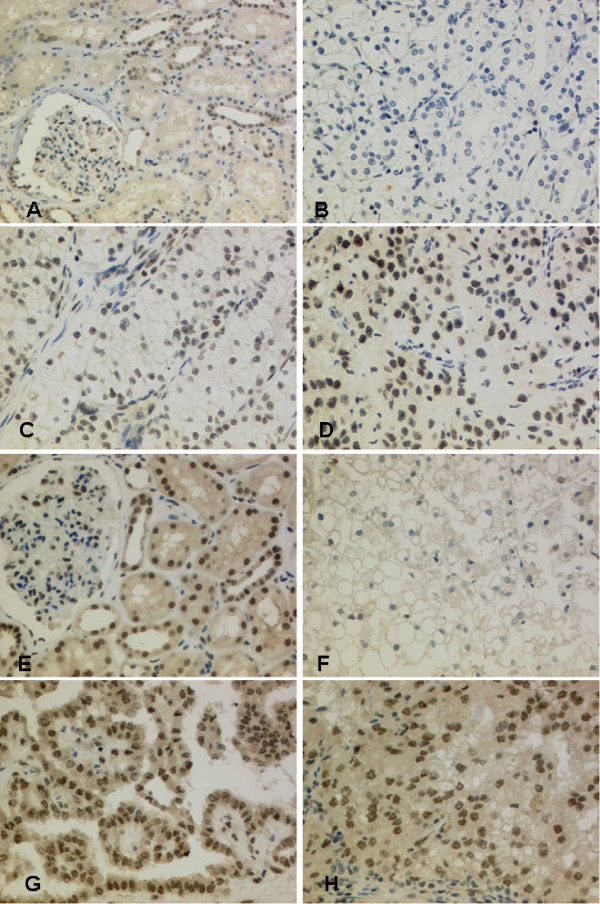
FBP1 and FBP3 expression in normal kidney and renal cancer. A) Normal renal tissue shows a moderate FPB1 expression in epithelia of distal tubules, whereas proximal tubules show no immunoreactivity. Podocytes and endothelia of the Bowman capsule are also FBP1 positive (20×). B) ccRCC lacking FBP1 expression (20×).C) ccRCC with moderate FBP1 immunoreactivity (20×). D) Example of a strong FBP1 expression in a ccRCC, 20×. E) Normal renal tissue with a strong FBP3 expression in epithelia of proximal and distal tubules (40×). F) FBP3-negative ccRCC (20×). G) FBP3 positive papillary RCC (20×). H) ccRCC with strong FPB3 expression (20×).